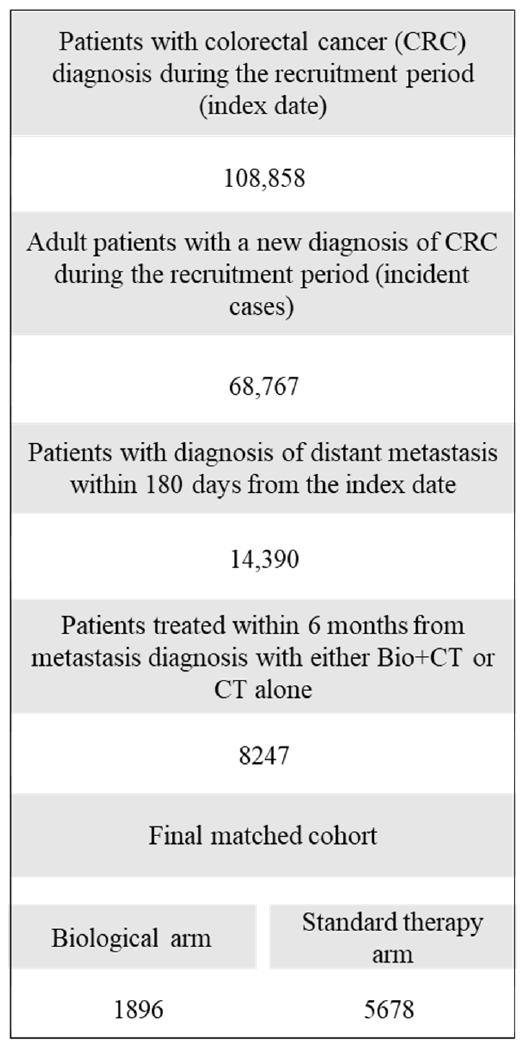
Figure 1. Flowchart of inclusion and exclusion criteria. FABIO project, Italy, 2010–2016. Table 1. Comparison between baseline characteristics of metastatic colorectal cancer patients belonging to the original and propensity score (PS)-matched cohorts on first-line treatment with biologic-based (bevacizumab or cetuximab) or standard chemotherapy alone. FABIO project, Italy, 2010–2016.